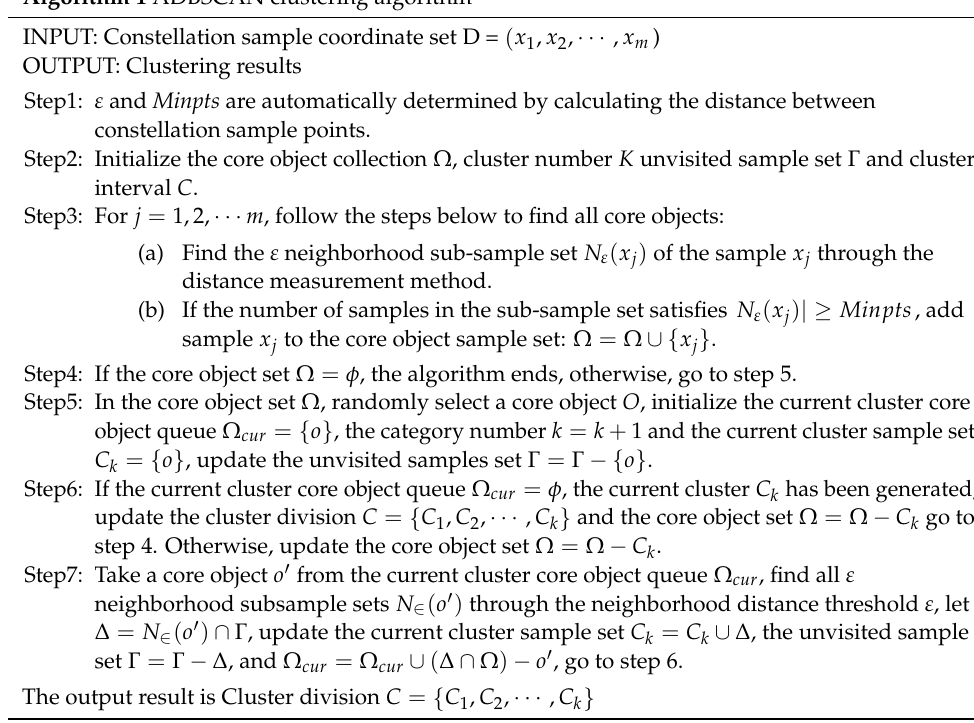
Algorithm 1 ADBSCAN clustering